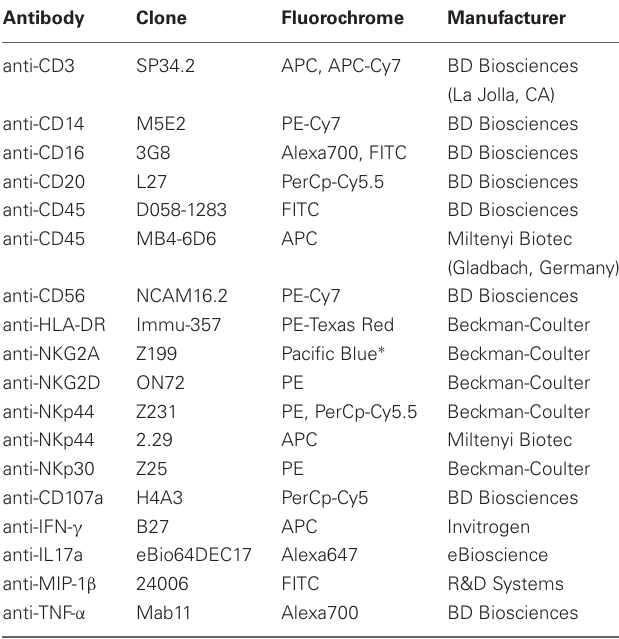
Table 1 | Antibodies used for flow cytometric analyses.